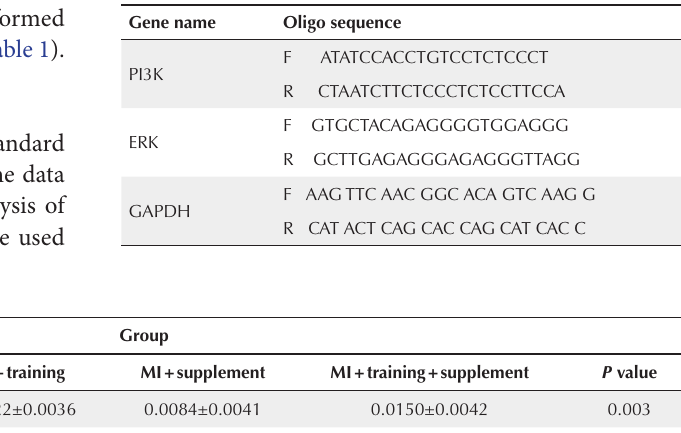
Table 1 . Primer sequences